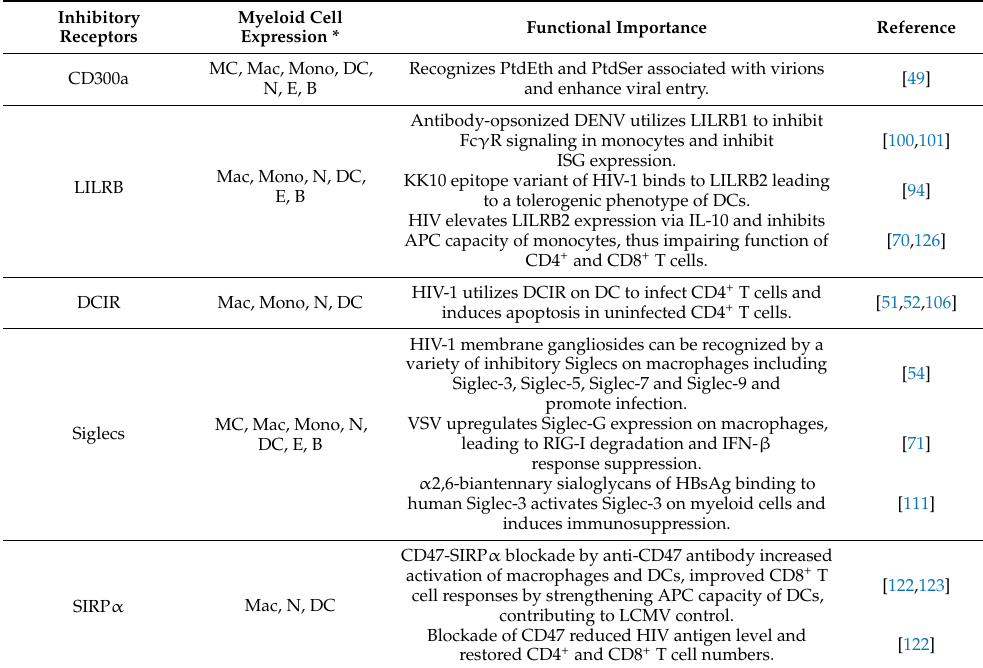
Table 1. Viral manipulation of inhibitory receptors on myeloid